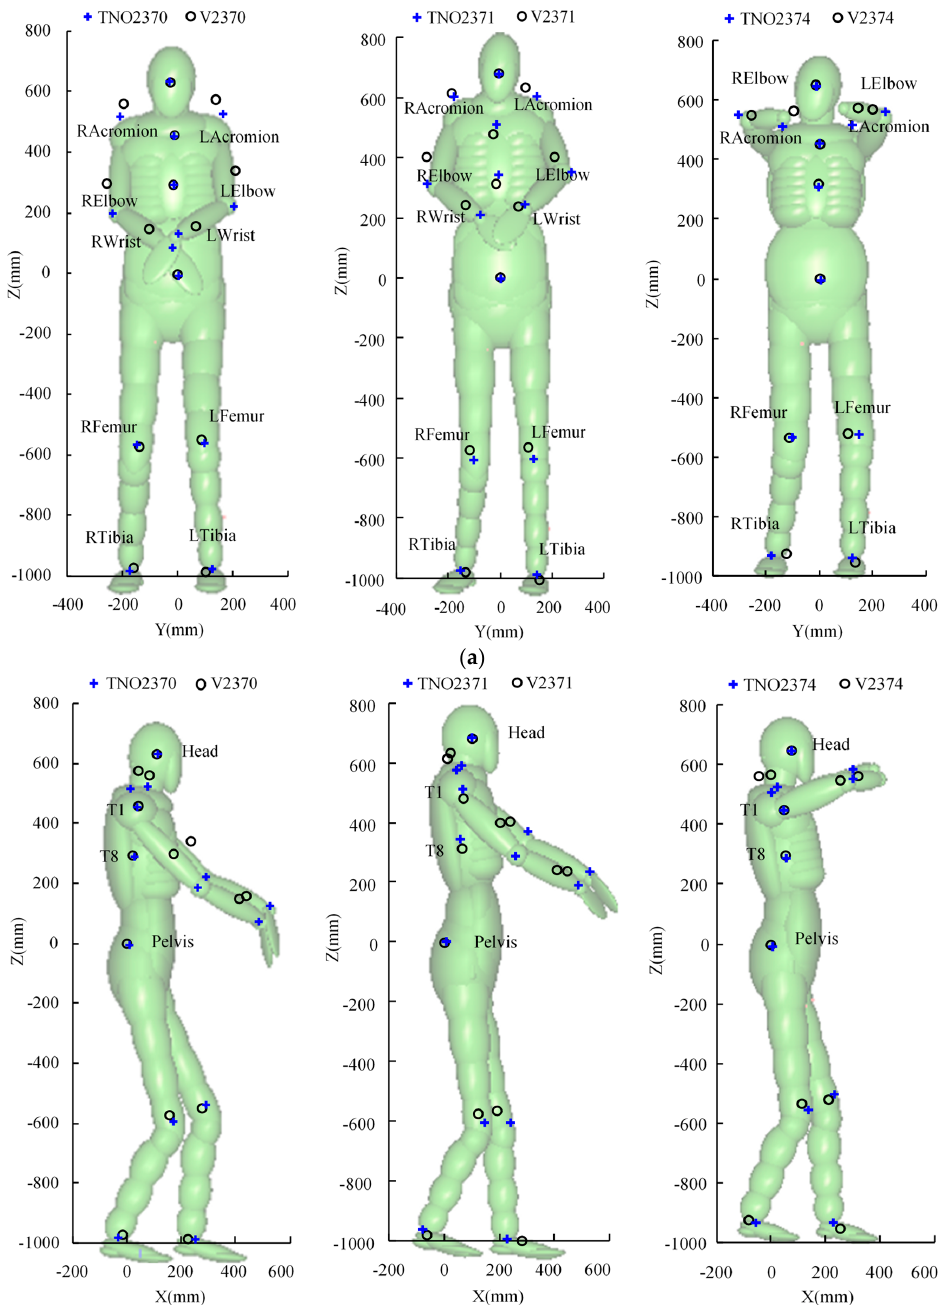
Figure 3. Postures over-plotted with Vicon marker positions from the experiments (aligned with the pelvis position with the model in the background) in case V2370, case V2370, and case V2374 [17]: ( a ) Y-Z plan; ( b ) X-Z plan.